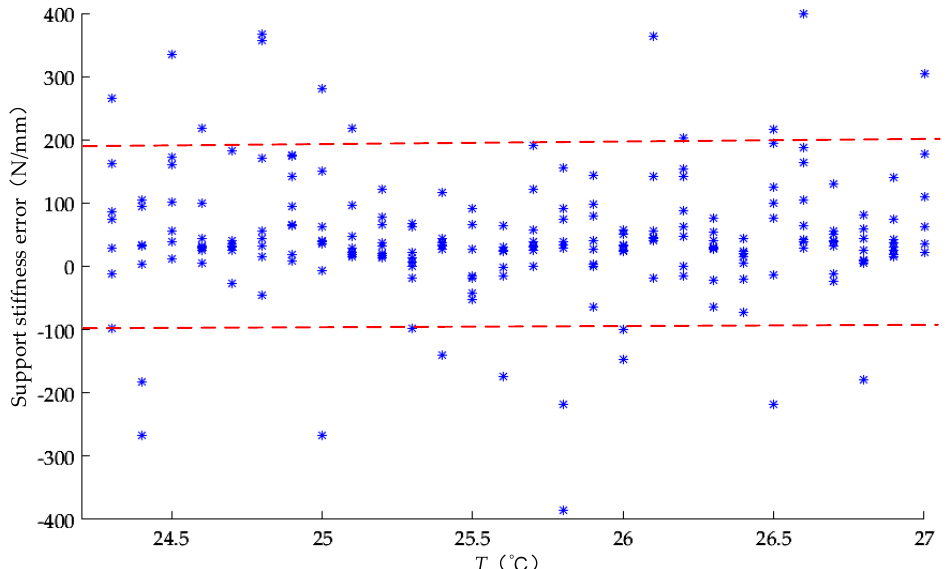
Figure 14. Support stiffness error with hydraulic oil with filtered air.